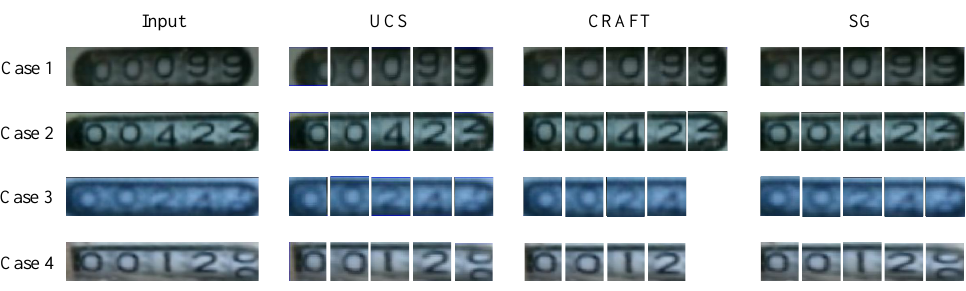
Figure 10. Comparison of segmentation methods. UCS is the uniform character segment- ing, CRAFT is the OCR text detector, and SG is the spatial guidance method we proposed.